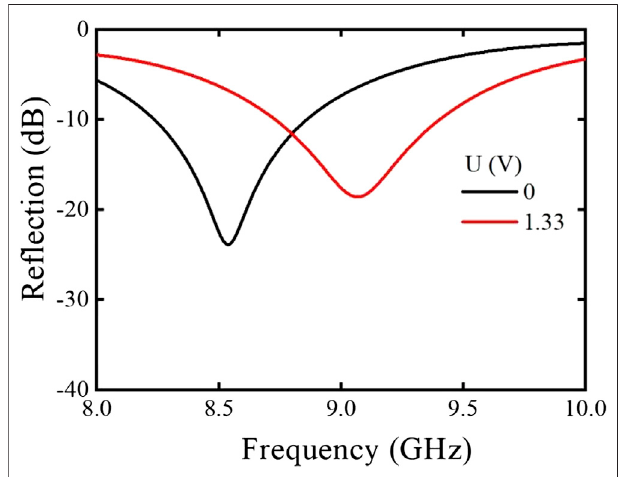
FIGURE 3 | The simulated re fl ection spectra of the active high impedance metasurface when the loaded PIN diodes are on-state (black line) and off-state (red line).